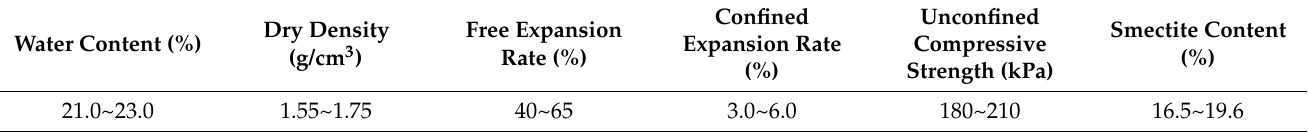
Figure 2. The expansive soil specimen in the field. ( a ) Crack distribution; ( b ) crack interface. Table 1. The physical and mechanical parameters of expansive Table 1. The physical and mechanical parameters of expansive soils.